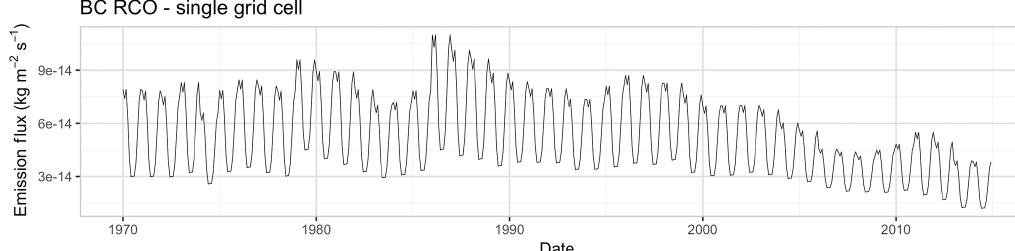
Figure 10. Time series plot for total BC emissions over time at the monthly level for a grid cell in Finland.